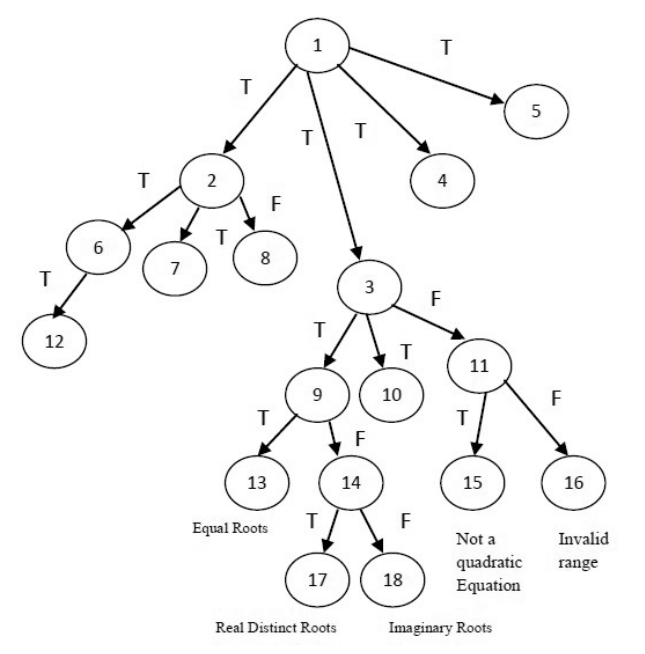
Figure 8. CDG of the quadratic equation